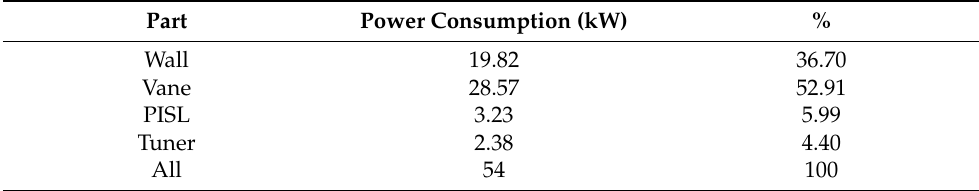
Table 7. Power consumption